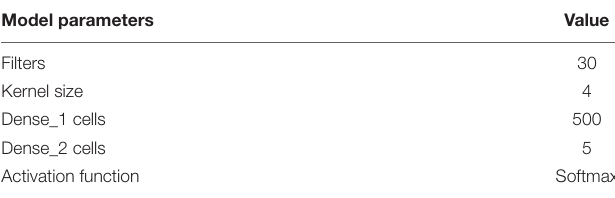
TABLE 1 | Parameters of the Improved